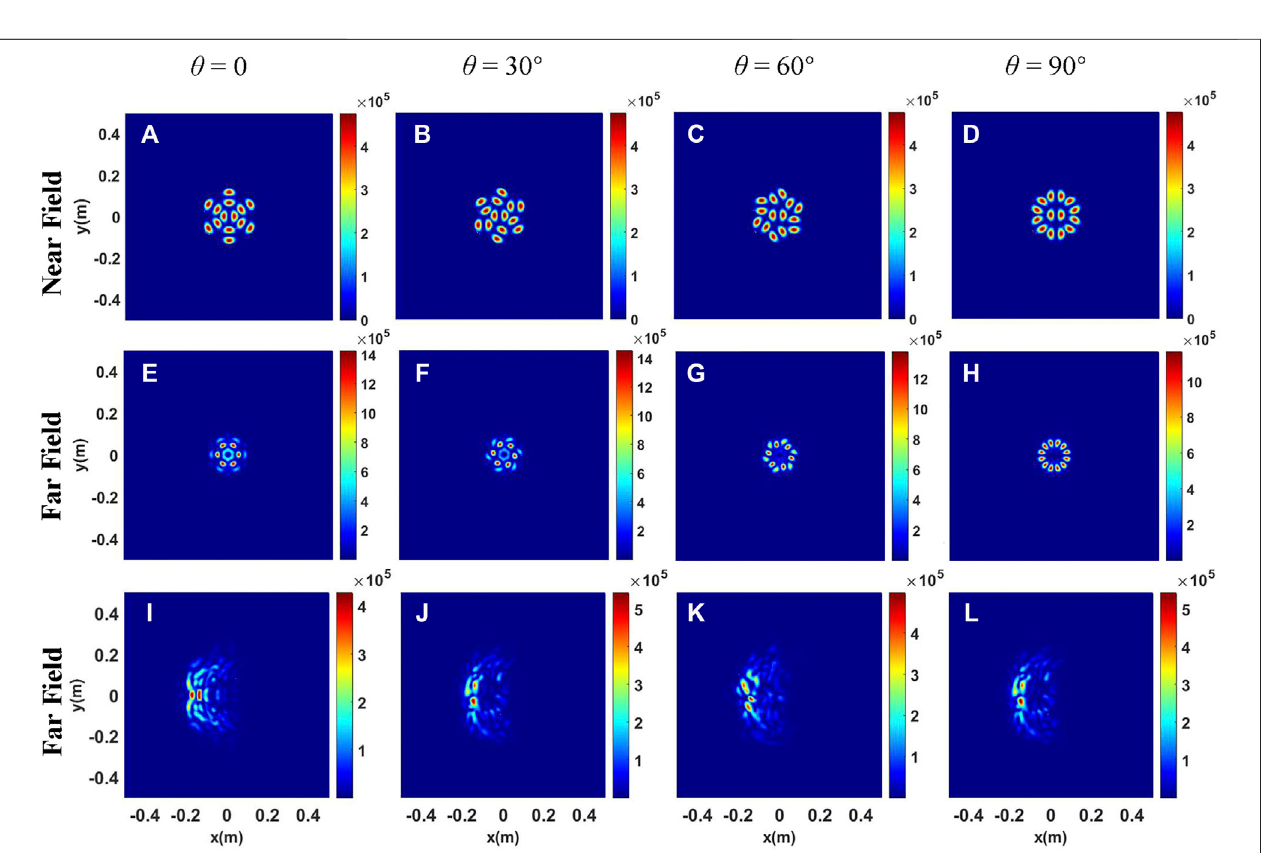
FIGURE 3 | Intensity distributions of the LP 11 mode beam array for different rotation angles of beamlets. (A – D) Intensity distributions at the initial plane; (E – H) Intensity distributions at the receiver plane in free space; (I – L) Intensity distributions at the receiver plane under thermal blooming.